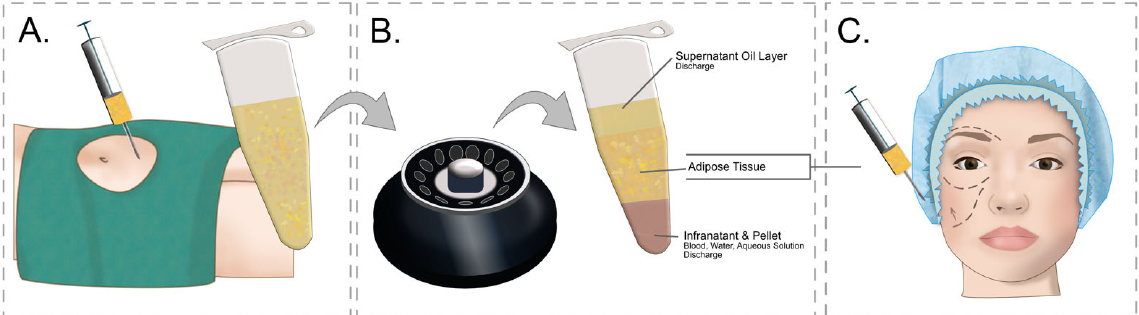
Figure 1. Study flow diagram and post hoc derivative prediction models: screening test and diagnostic test results. ( A ) Adipose tissue is collected from the recipient site—most often the abdomen or thighs. After the skin is anesthetized with a local anesthetic, an incision is made in the skin through which a syringe with a cannula is inserted and Klein’s solution is administered subcutaneously, which anesthetizes the tissues and causes vasoconstriction, minimizing surgical bleeding. After the tissues are anesthetized, a cannula with an attached syringe is inserted through the opening in the skin, in which a vacuum is created. The sliding movements of the cannula detach and suck off the fat. ( B ) After collecting the fat, it is centrifuged in order to separate it from other fractions. The centrifuged fat is then crushed by passing it through special narrowed connectors. ( C ) After the fat is prepared, it is cannulated into the regions where fat loss occurs.